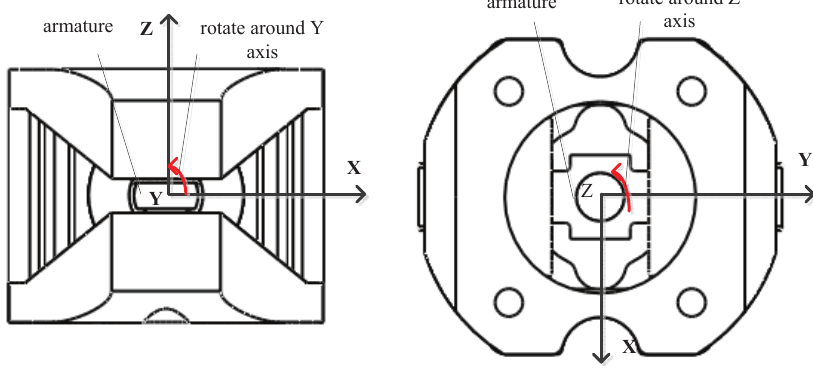
Figure 9. Rotational errors of the torque